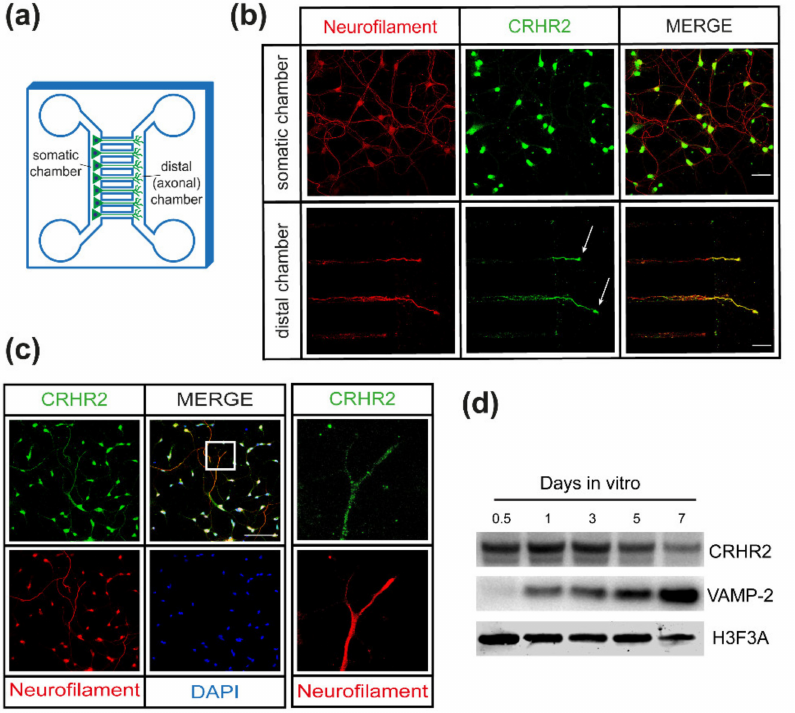
Figure 3. CRHR2 localises at the axonal tips of growing neurons and its expression decreases with synaptogenesis. ( a ) Graphical representation of the microfluidic devices (MFC) used in the study, showing the somatic chamber, where neurons are plated, connected to the distal (axonal) one by microgrooves where axons elongate in a directional manner. ( b ) Representative immunostaining of SCMNs cultured for 7 days in MFC showing the expression of neurofilaments (red, to label the axonal cytoskeleton) and CRHR2 (green) on axon tips (arrows). Top panels show the somatic chamber and bottom panels the axonal one. Scale bars = 10 µ m. ( c ) Representative immunostaining of SCMNs after 24 h of culture at low density showing the expression of neurofilaments (red) and CRHR2 (green). The right panel shows a magnification of the inset. Scale bar = 10 µ m. ( d ) Representative Western blot showing the expression of CRHR2 and VAMP-2 in CGNs at different days in culture. Expression of histone H3 represents a loading